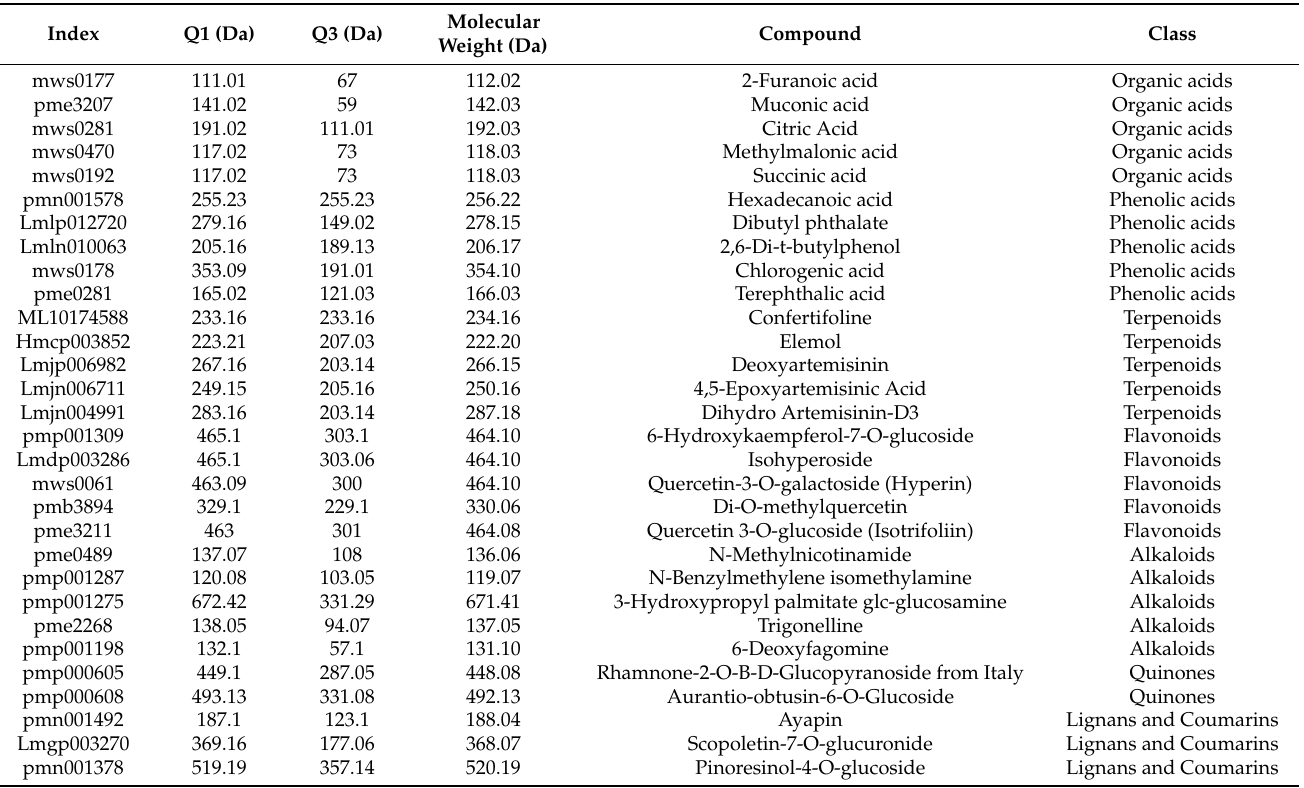
Table 2. The 30 representative active components in